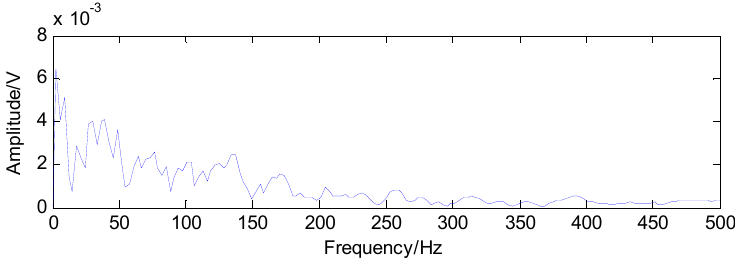
Figure 23. Envelope spectrum of the transient impact component in Figure 20.